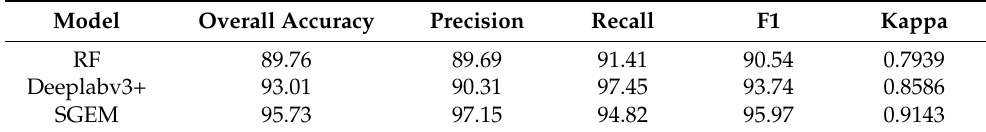
Table 3. Accuracy evaluation of three models.